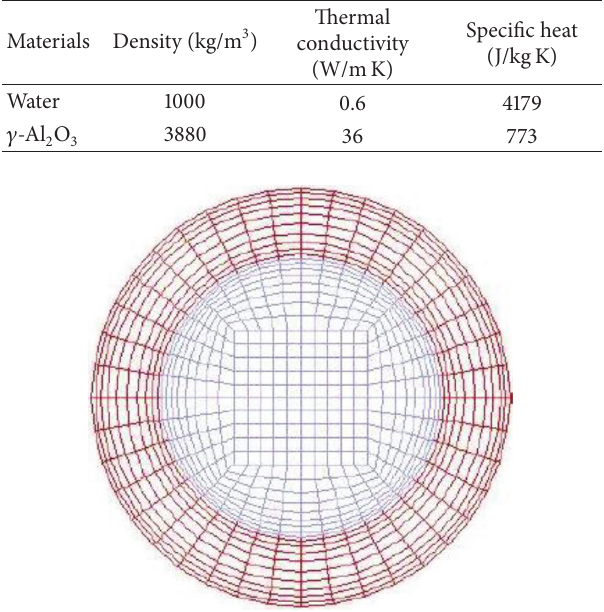
Figure 1: Geometrical configuration for present